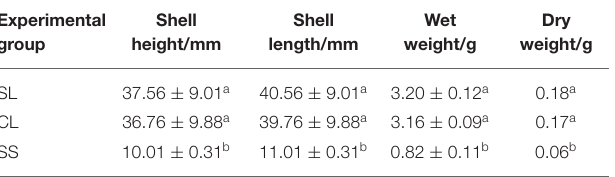
TABLE 1 | Biological data of P. f. martensii in the experiments.